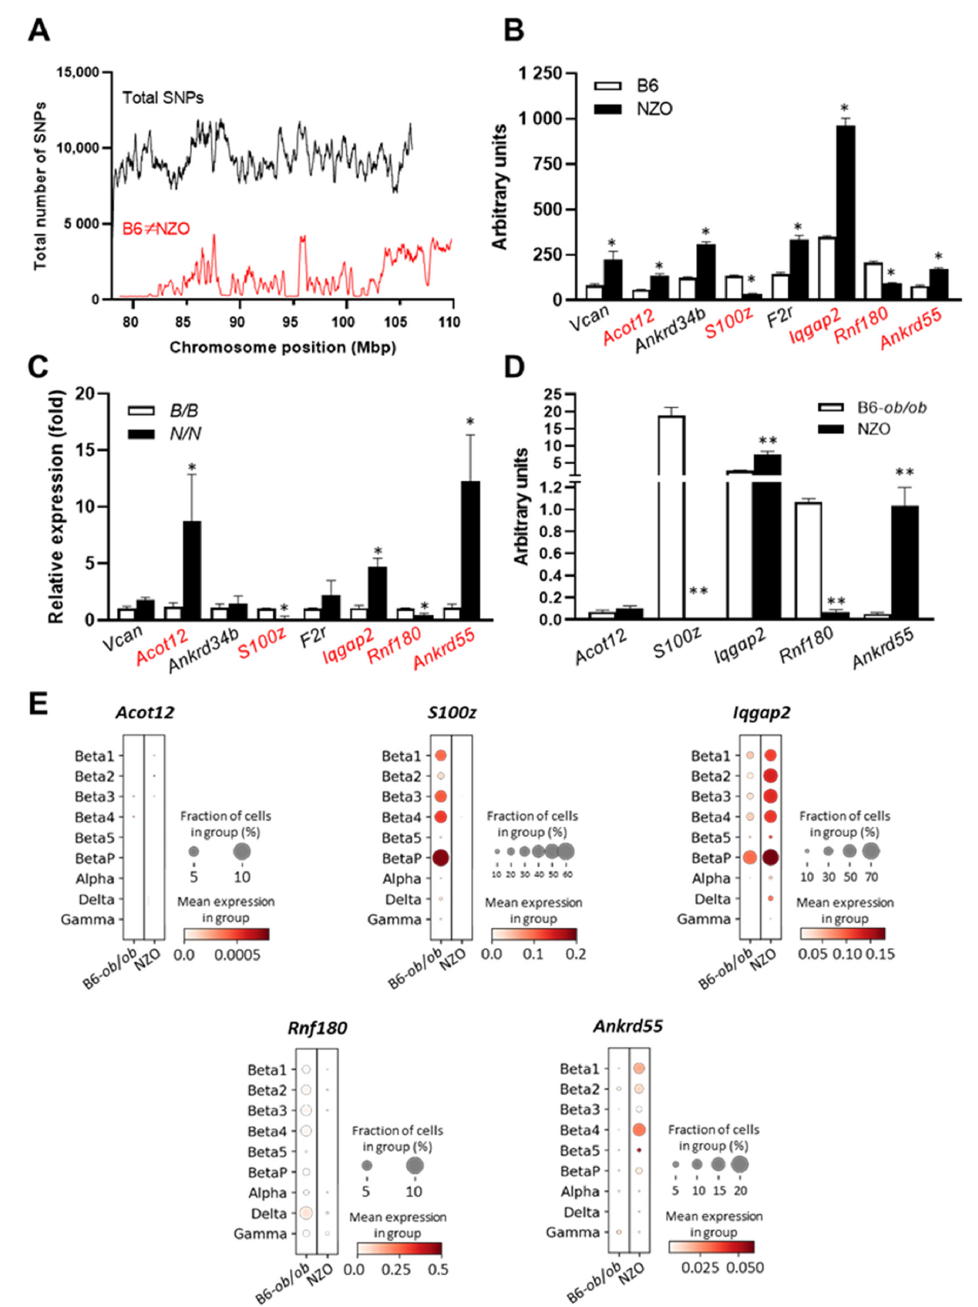
Figure 3. Combined approach of haplotype and gene expression analysis in islets for the identi- fication of gene variants within the Nidd13/NZO locus. ( A ) Haplotype map of single nucleotide polymorphisms (SNPs) within the critical region of Nidd13/NZO (78.0–120.4 Mbp). Black line: total number of SNPs (all SNPs annotated for the B6 reference genome). Red line: SNPs according to B6 (cid:54) = NZO. ( B ) Genes within the critical Nidd13/NZO interval displaying a differential expression in pancreatic islets of parental mice, ( C ) Nidd13/NZO.42.2 congenics, and ( D ) B6- ob/ob versus NZO mice. ( E ) Single-cell data of Nidd13/NZO candidate genes. Dot plot representing expression levels by color code and fraction of cells expressing the gene. Expression levels are depicted from white to red (low to high), and dot size presents fraction of cells expressing the indicated gene. * p < 0.05; ** p <